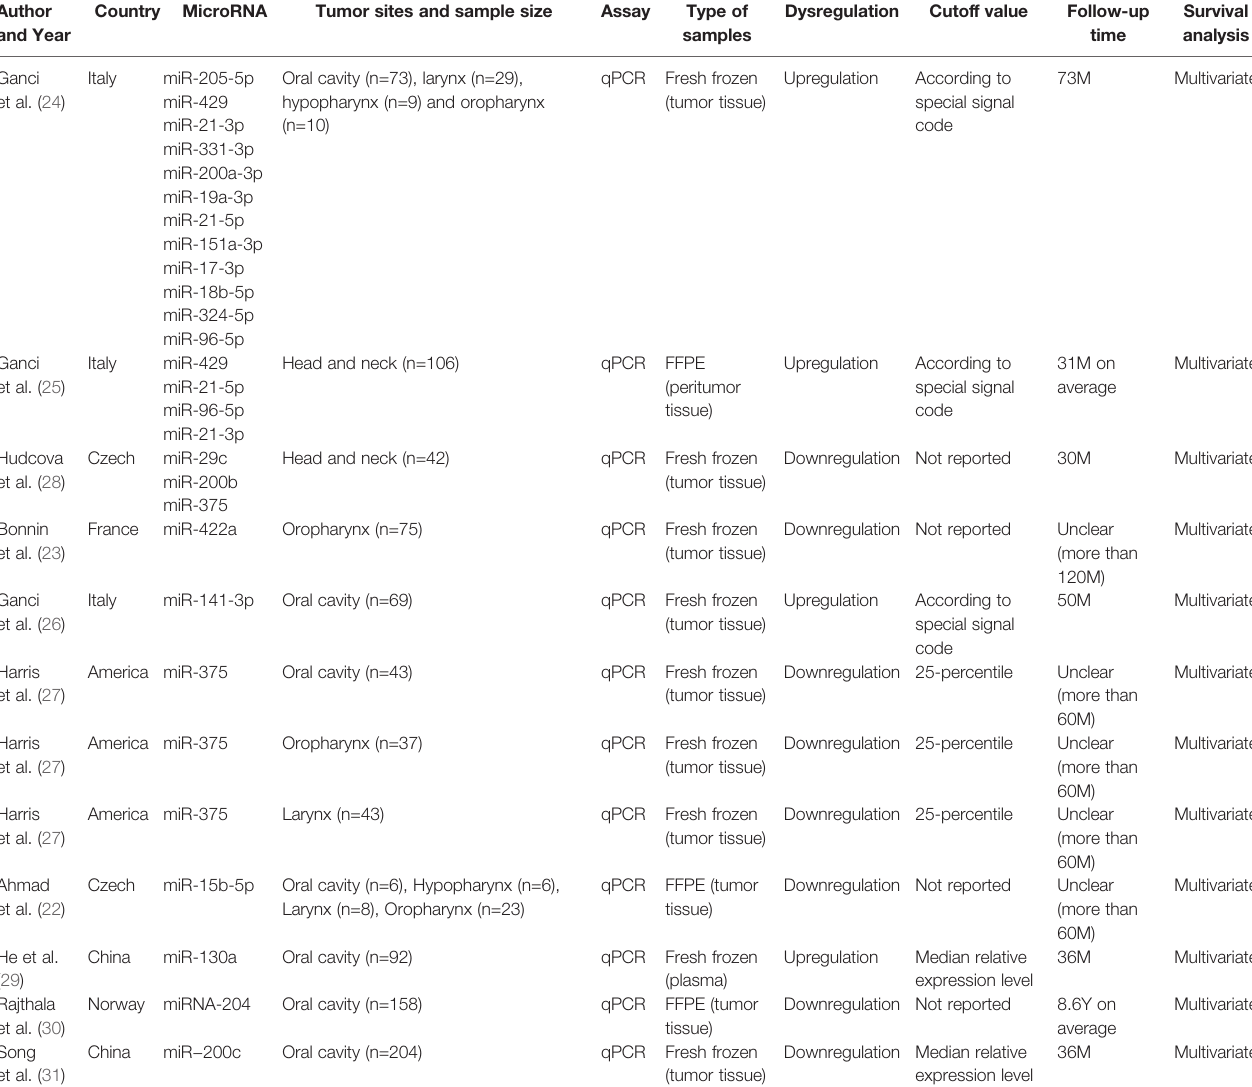
TABLE 1 | Detailed characteristics and NOS scores of included studies investigating RFS.